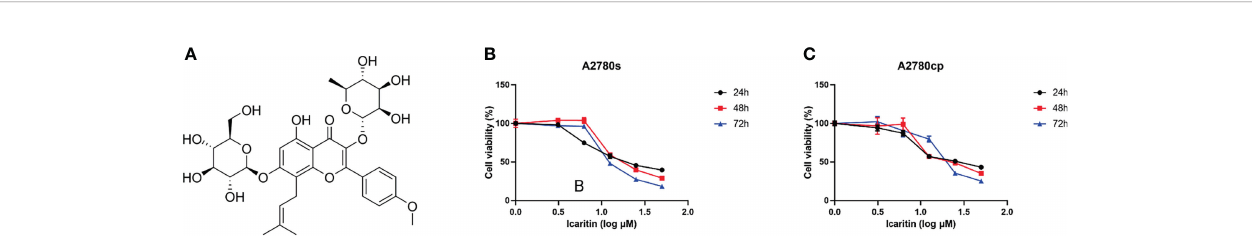
FIGURE 1 | Chemical structure of icaritin and its effects on cell viability in A2780s and A2780cp cells. (A) The chemical structure of icaritin. (B) A2780s cells were treated with different concentrations (0 – 50 m M) of icaritin for 24, 48, and 72 h. The cell viability was measured by MTT assay. The data are indicated as means ± SEM of three independent experiments. (C) A2780cp cells were treated with different concentrations (0 – 50 m M) of icaritin for 24, 48, and 72 h. The cell viability was measured by MTT assay. The data are represented as means ± SEM of three independent